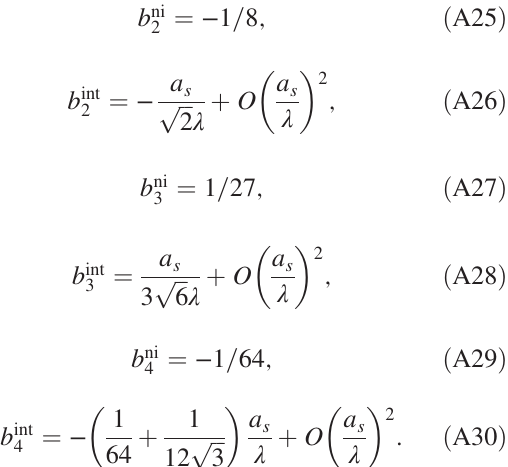
ffiffiffiffiffiffiffiffiffiffiffiffi p ð 2 Þ T=T . C F 0 is the previously obtained